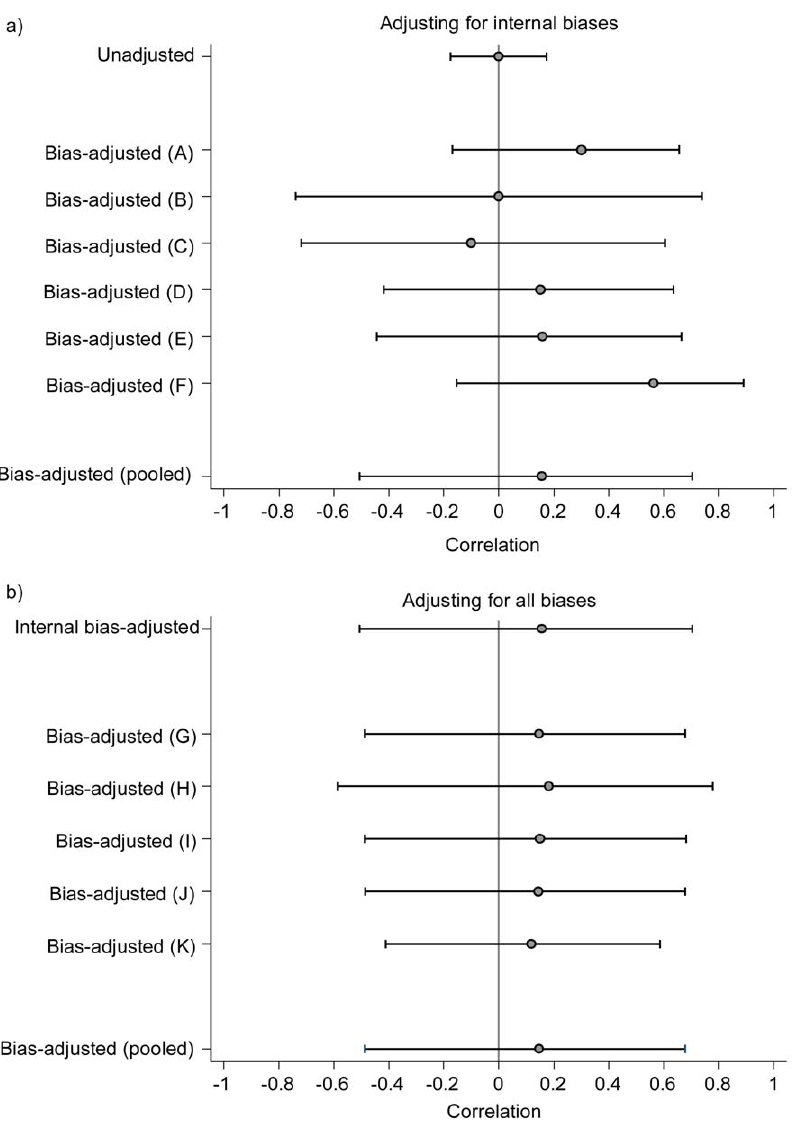
Figure 2. Adjusting for bias for the study by Johnson et al (23). Shown is the impact on correlations (95% confidence intervals) of adjusting for bias for the assessors (A–F and G–K) separately and combined using median pooling. Values on the left hand side of the x-axis represent a negative correlation between physical activity and change in adiposity, i.e. greater baseline physical activity is related to a smaller increase in adiposity.